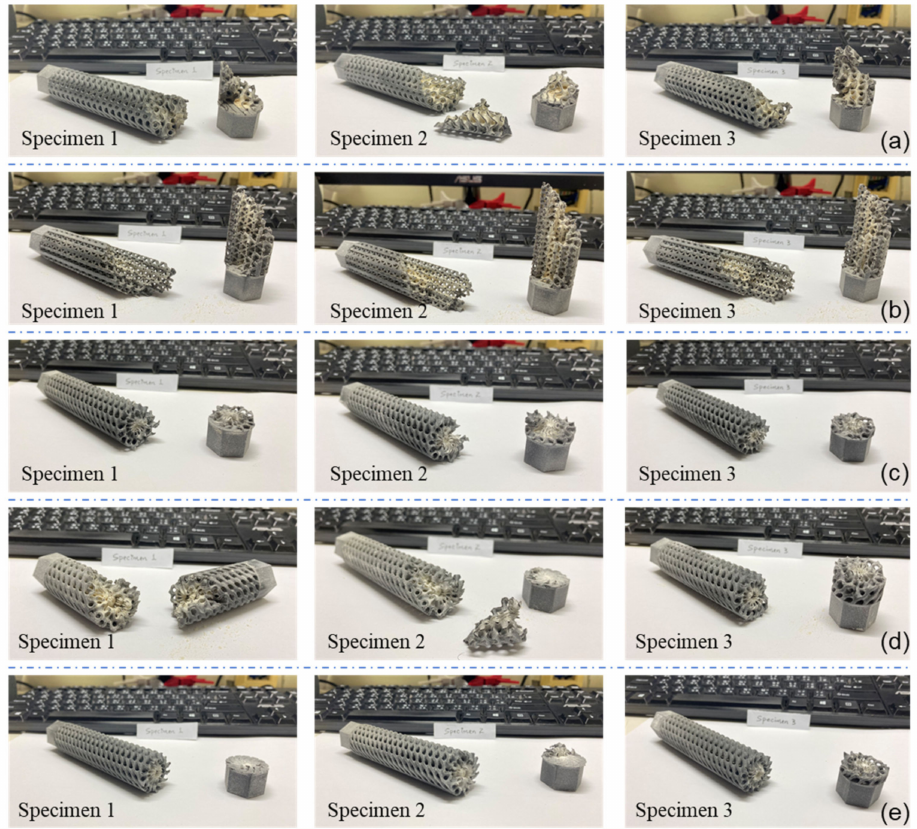
Figure 18. Mode of failure for different functionally gradient design configurations investigated in the present study. ( a ) D, ( b ) VI, ( c ) CA, ( d ) CR, and ( e )